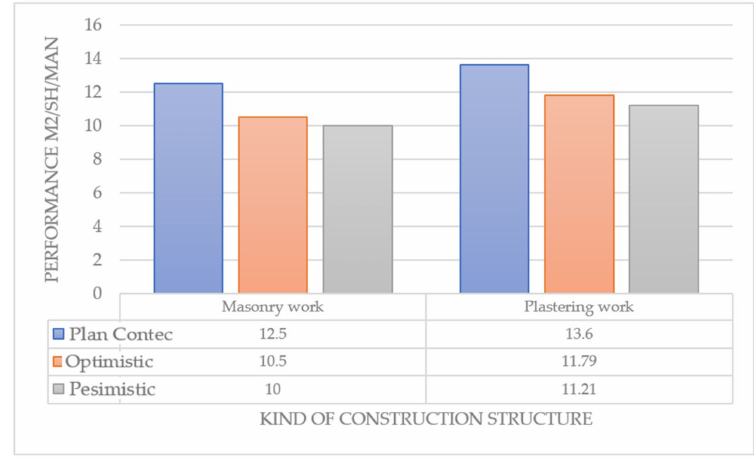
Figure 15. Productivity of masonry and plastering works.